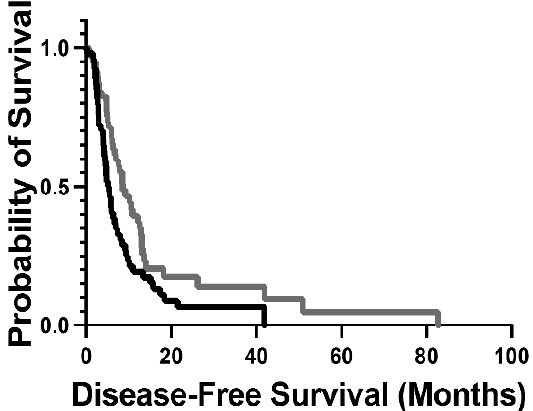
Figure 5. KM analysis comparing DFS for case IDs representing the upper (black line) and lower 50th percentile (grey line) CIITA RNAseq values for the entire TCGA-GBM dataset. (logrank p -value = 0.013; Table S10).